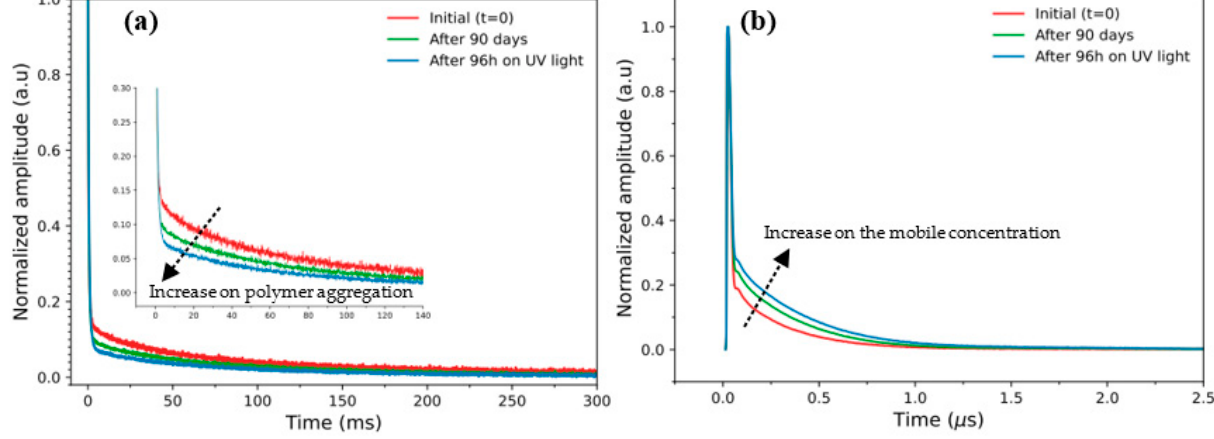
Figure 1. TD-NMR results obtained from ( a ) CPMG and ( b ) RK-ROSE signals for the ‘IAC Alvorada’ cultivar at zero time (initial color) (T0, red line), prolonged darkening after 90 days exposure to fluorescent light (12-h photoperiod) (T90, green line) and accelerated darkening after 96 h of exposure to UV-C light (T96, blue line).